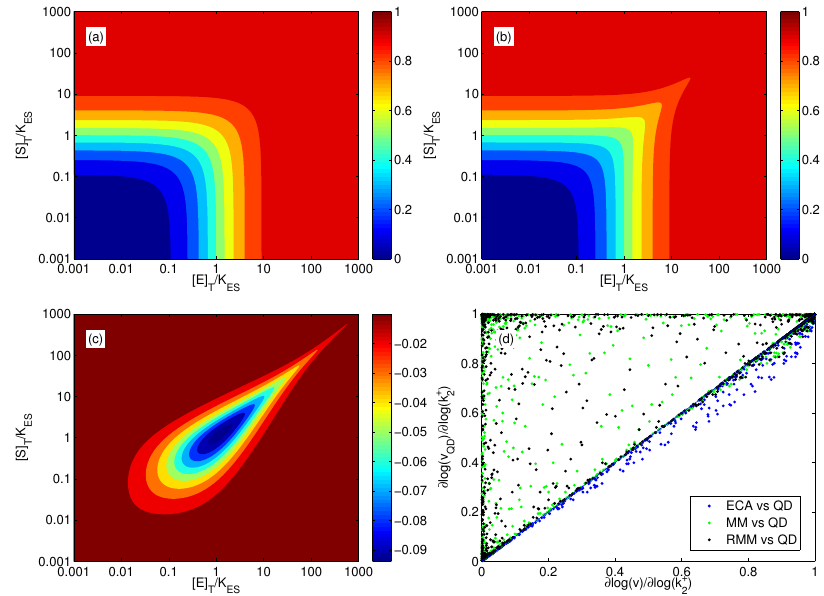
Figure 1. (a) ECA-kinetics-predicted normalized sensitivity of the reaction velocity with respect to the maximum product genesis rate k + ; (b) predictions by the quadratic kinetics; (c) the normalized difference (cid:0) a QD − a ECA (cid:1) / (cid:0) a QD + a ECA (cid:1) between the quadratic kinetics 2 predictions a QD and the ECA kinetics predictions a ECA ; (d) comparison of normalized sensitivity predicted by different kinetics.